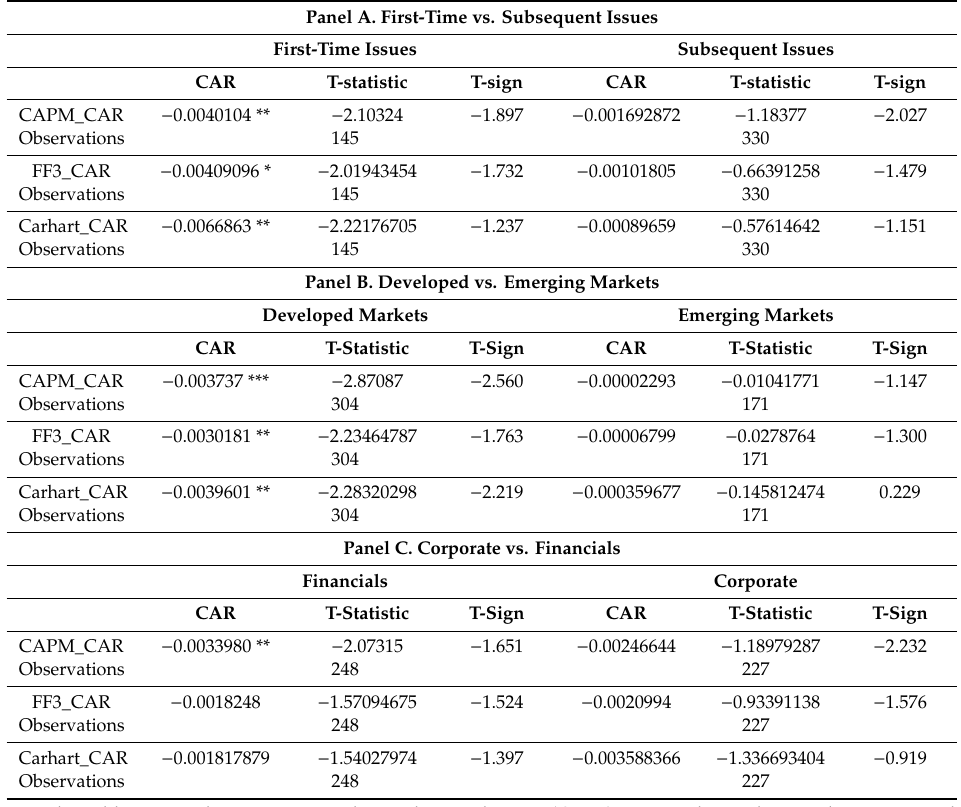
Table 4. Heterogeneity in stock market